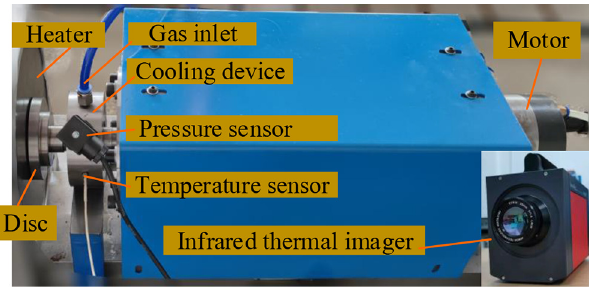
Fig. 21. Experimental setup for infrared thermographic